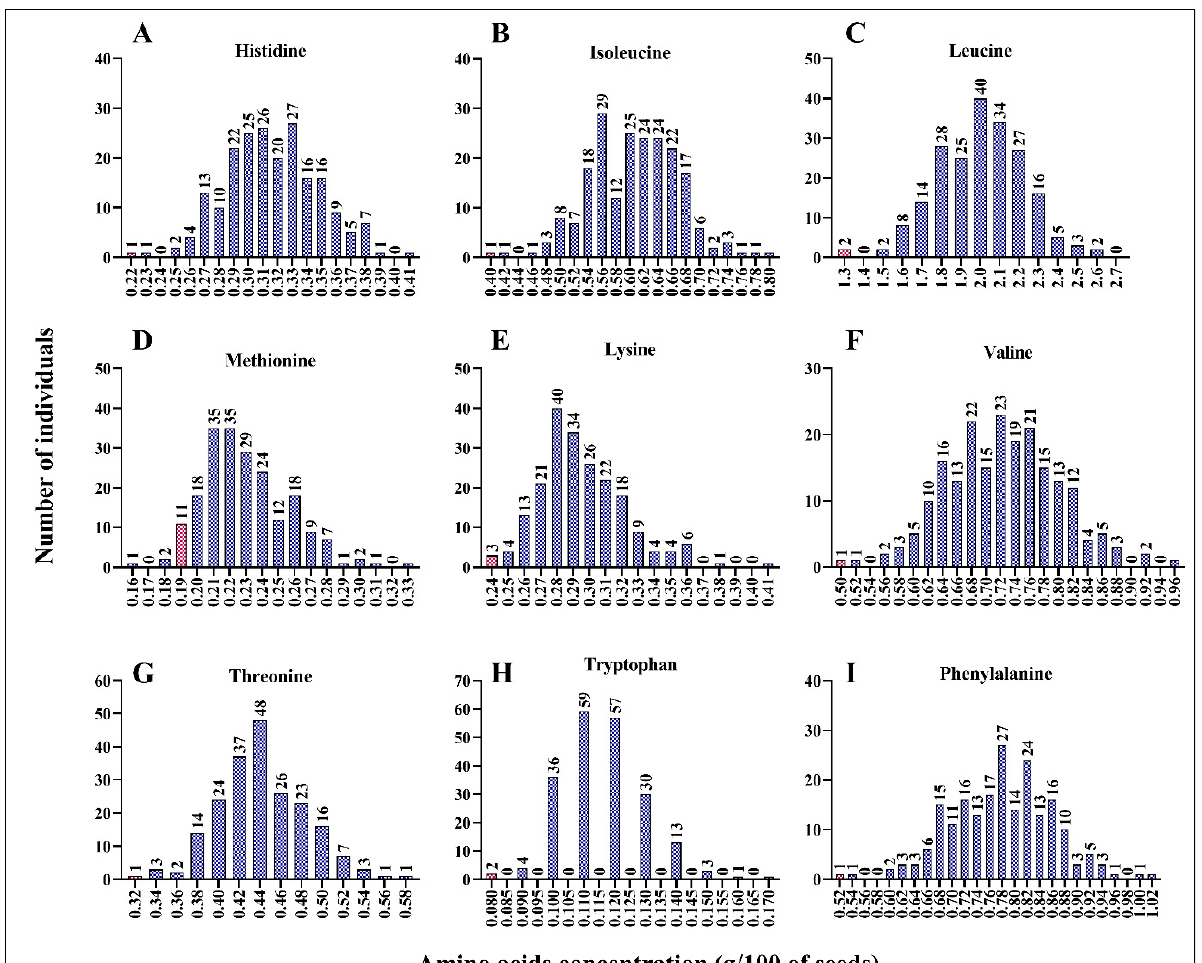
Figure 2. Mutant lines with various concentrations of the essential amino acids, histidine ( A ), isoleucine ( B ), leucine ( C ), methionine ( D ), lysine ( E ), valine ( F ), threonine ( G ), tryptophan ( H ), and phenylalanine ( I ). The x value indicates g/100 g of dry seed sample. Total protein was extracted from 100 g of seeds and the amino acids were quantified. Control line (BTx623) is indicated by a red bar in each panel.